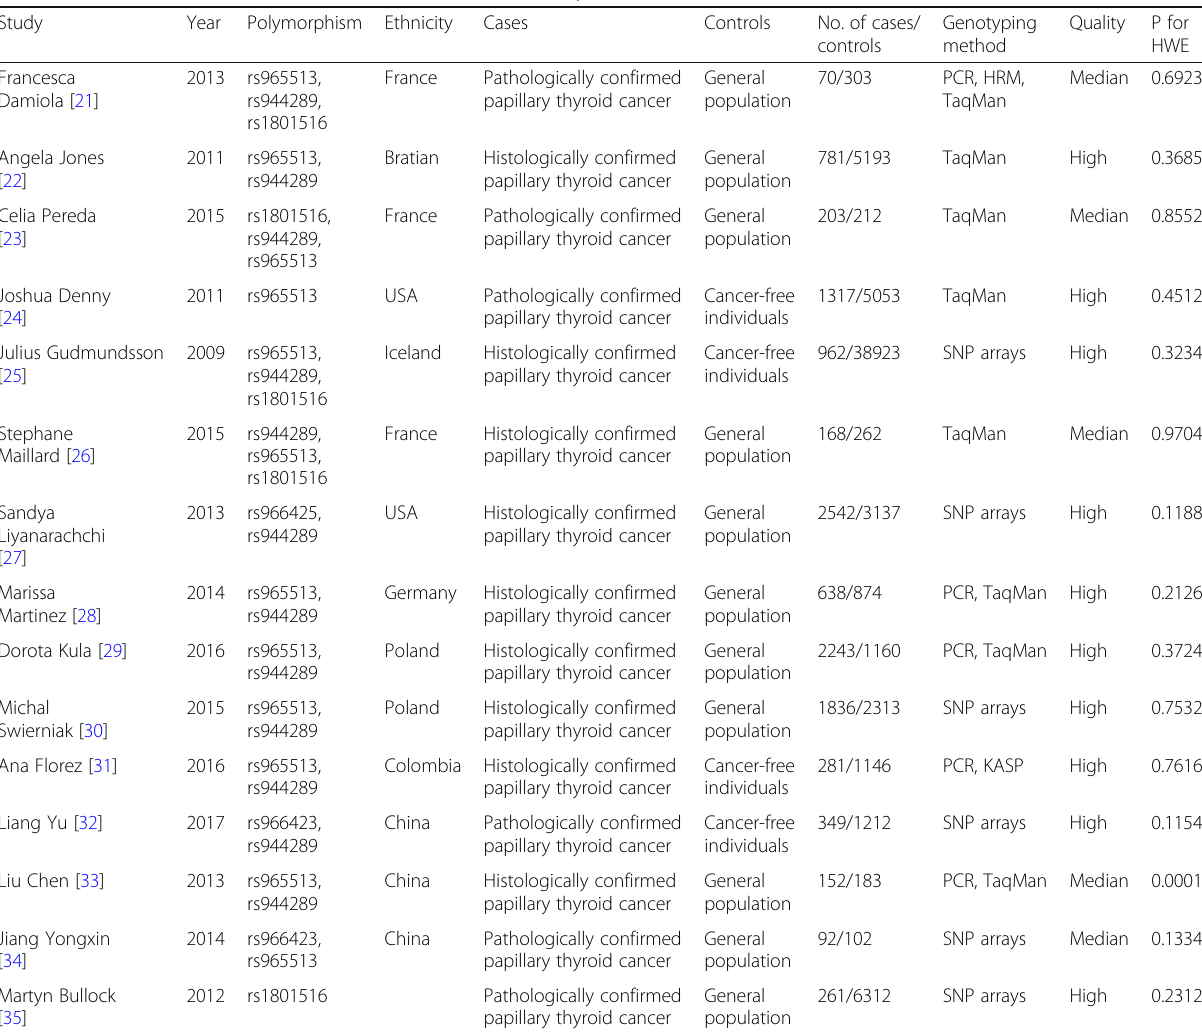
Table 1 Characteristics of the studies included in the meta-analysis